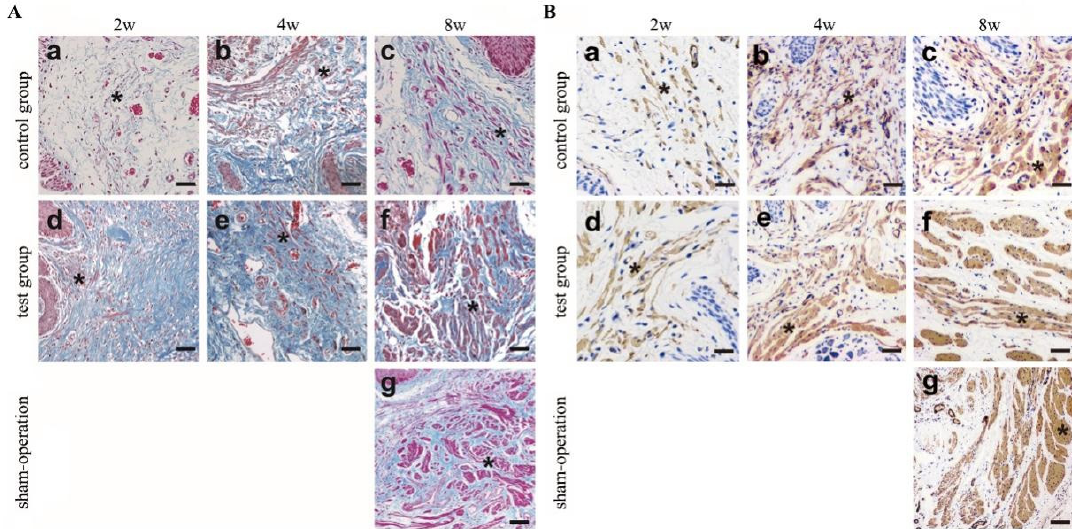
Figure 4. Masson’s trichrome and immunohistochemical staining with α -SMA to identify the SMCs. ( A ).The results showed that Masson's trichrome stained. The number of SMCs gradually increased with time (2w to 8w). At 2nd, 4th, and 8th week after surgery, the SMCs proliferation of the central zone in the control group (a–c) and test group (d–f). Until 8th week, there were detailed muscle bundles present both in control group ( c ) and test group (f). The number of SMCs in test group (f) were more than that in control group (c) and the muscle bundles in test group (f) were thicker than that in control group (c). However, the muscle bundle thickness of the control group and the test group is not as good as that of the sham operation group(Figure 4A(g)), by Masson`s trichrome staining ( left ). ( B ).The results of α -SMA staining once again confirmed the results of Masson's tri- chrome staining to SMCs. From 2nd to 8th week after surgery, the SMCs gradually increased in both the control group (a–c) and test group (d–f). At 8th week, both the control group (c) and the test